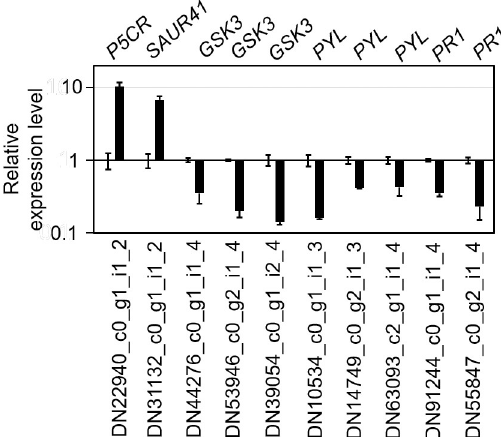
Fig 9. qRT-PCR validation of the RNA-seq results. Control group was set as 1, and the black column represented the relative expression of DEGs in the graphene-treated group.